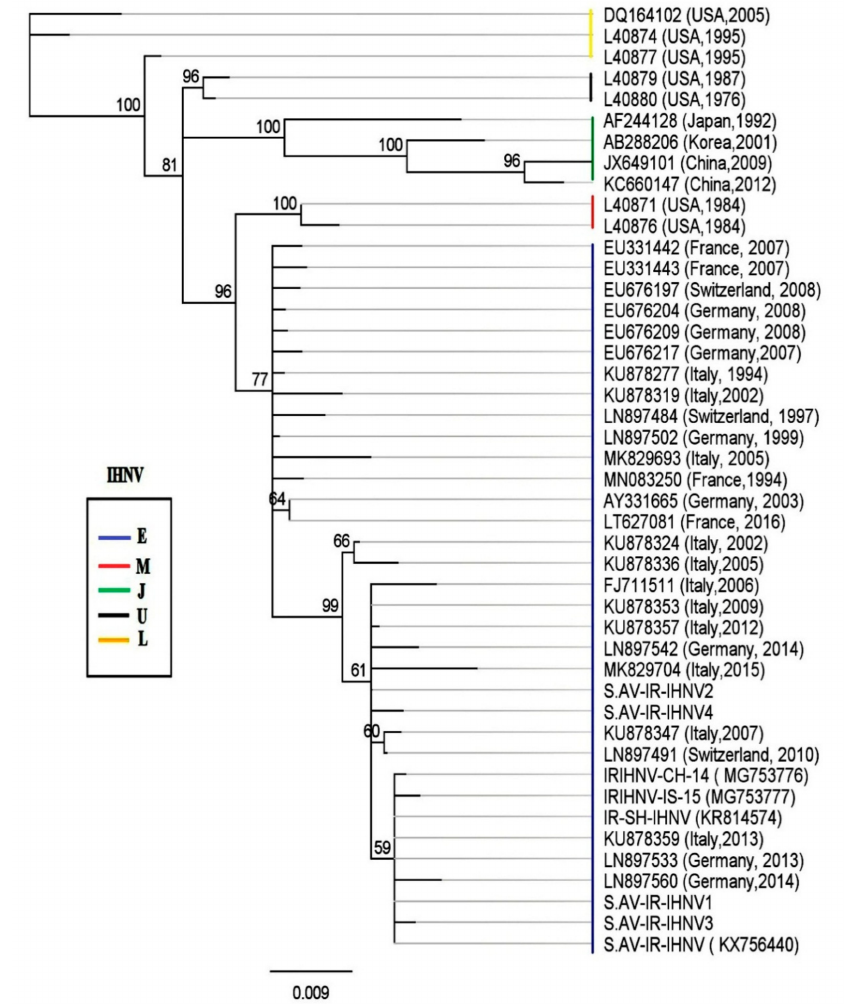
Figure 4. Phylogenetic analysis of Iranian isolate of IHNV based on the partial nucleotide sequences of G gene (693 bp). The phylogenetic trees were constructed using the Geneious Prime (Neighbor-joining with the HKY model and bootstrap replicates of 1000). The Iranian isolate of IHNV (S.AV-IR-IHNV1- S.AV-IR-IHNV4) was classified as a European (E) genogroup (GenBank accession numbers are listed in Table